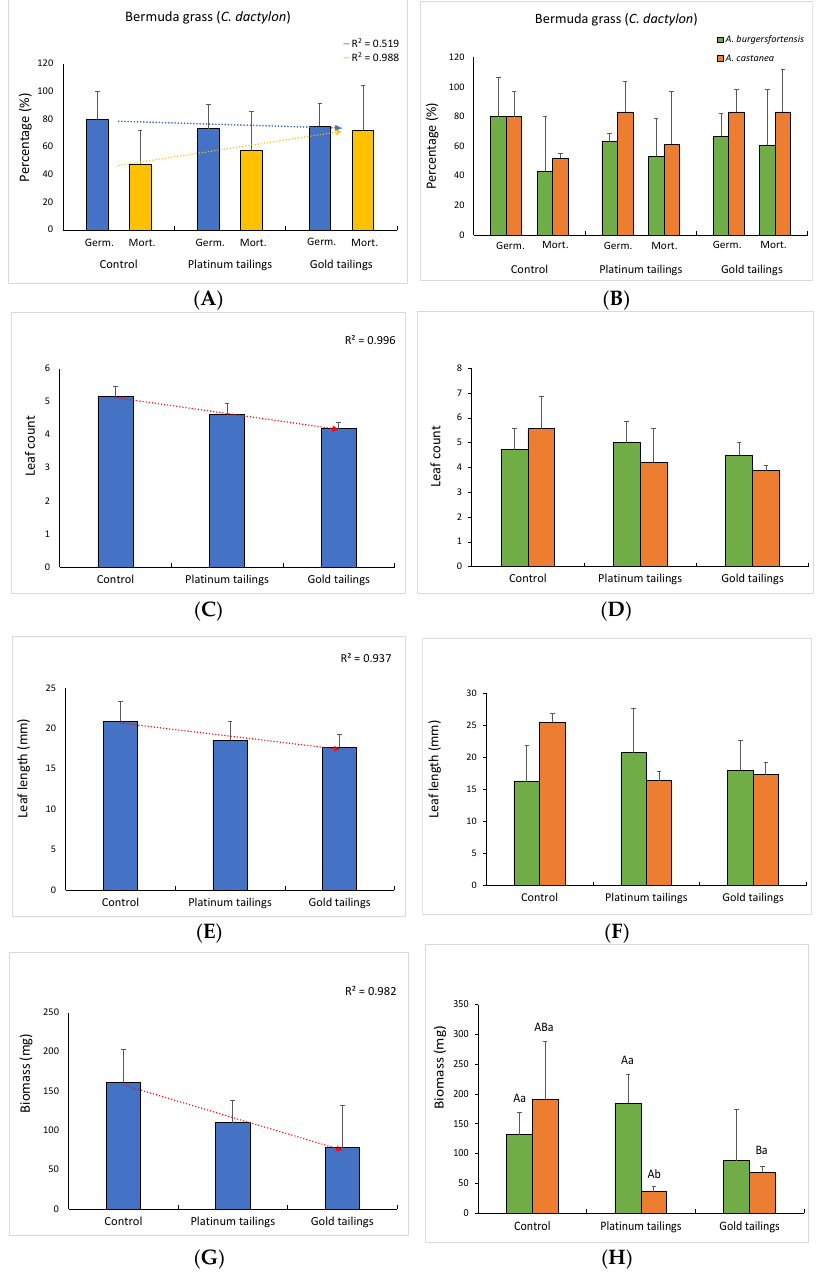
Figure 3. Mean values (± sd) and regression curves for developmental parameters of Bermuda grass considering only the soil treatments ( A , C , E , G ) and the soil treatments in the presence of aloes ( B , D , F , H ). Different upper-case letters: significant differences ( p < 5%) among individuals in differ- ent soil treatments in the presence of the same aloe species. Different lower-case letters: significant differences among individuals grown with different aloe species, in the same soil treatment.